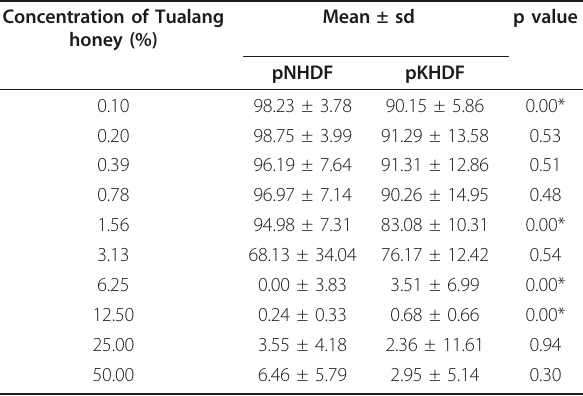
Table 2 Cell proliferation in pNHDF and pKHDF after being treated with Tualang honey between 0.10% to 50% concentration Concentration of Tualang honey